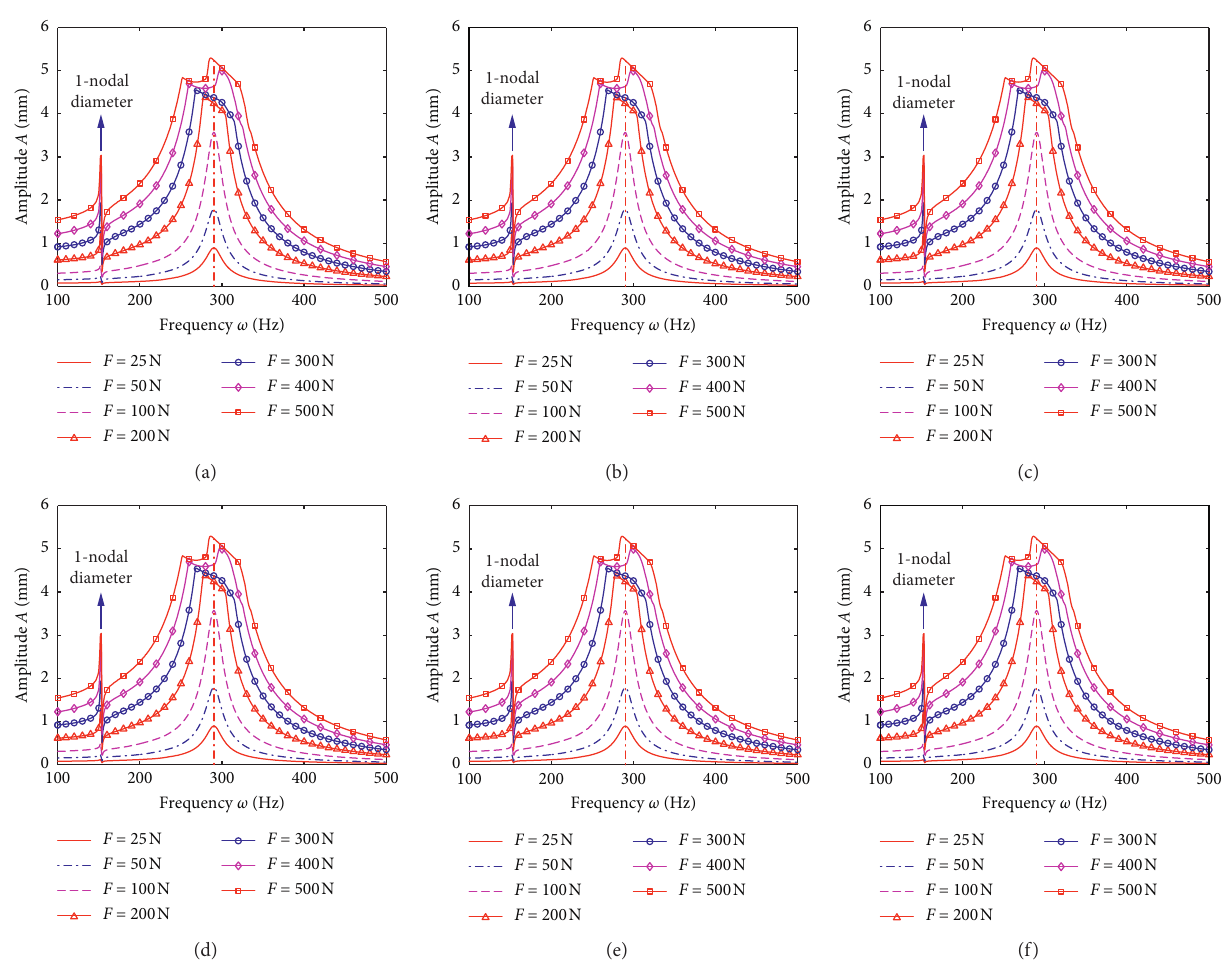
Figure 4: Amplitude-frequency response curves of beam 1 to beam 6 for different excitation levels: (a) beam 1, (b) beam 2, (c) beam 3, (d) beam 4, (e) beam 5, and (f) beam 6.